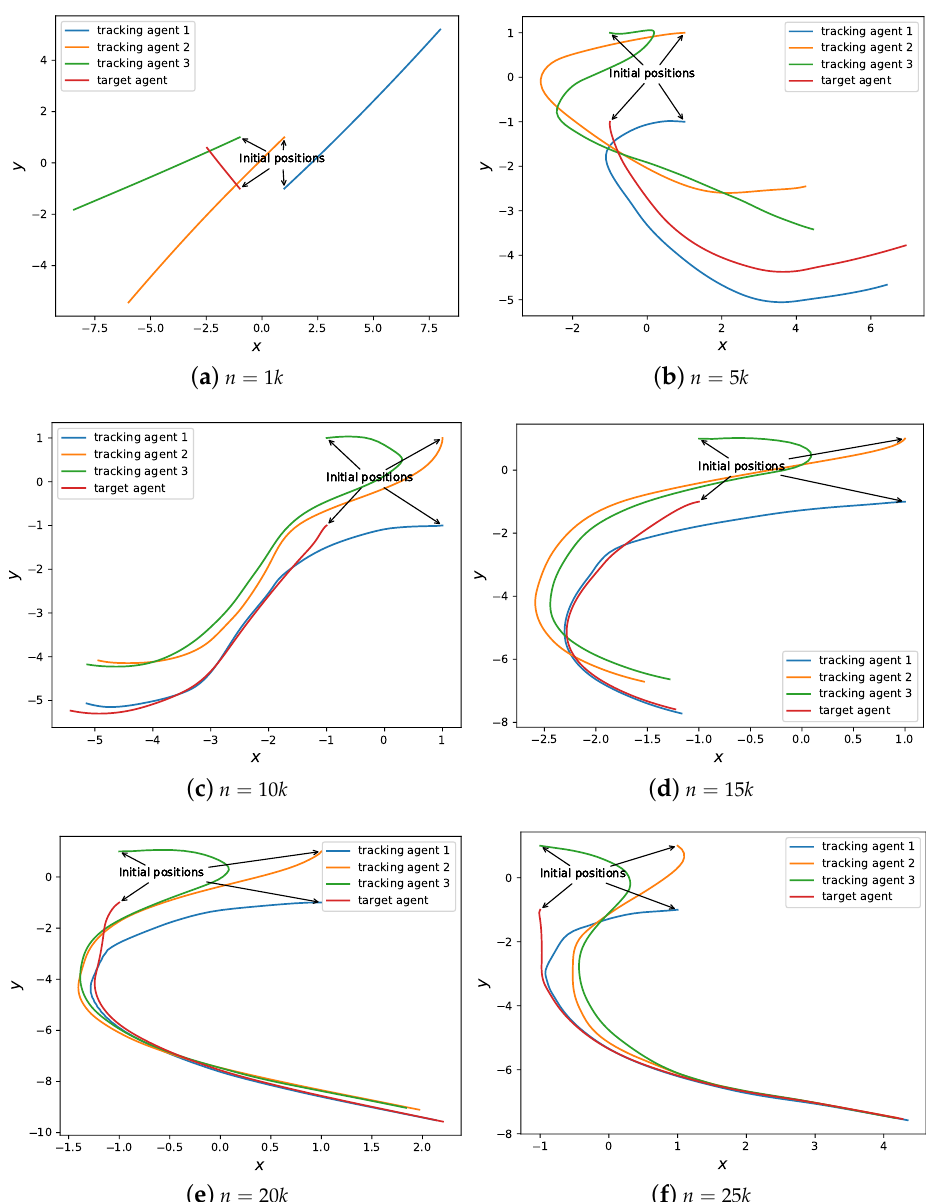
Figure 6. The trajectories of the agents tested on the model after n episodes of